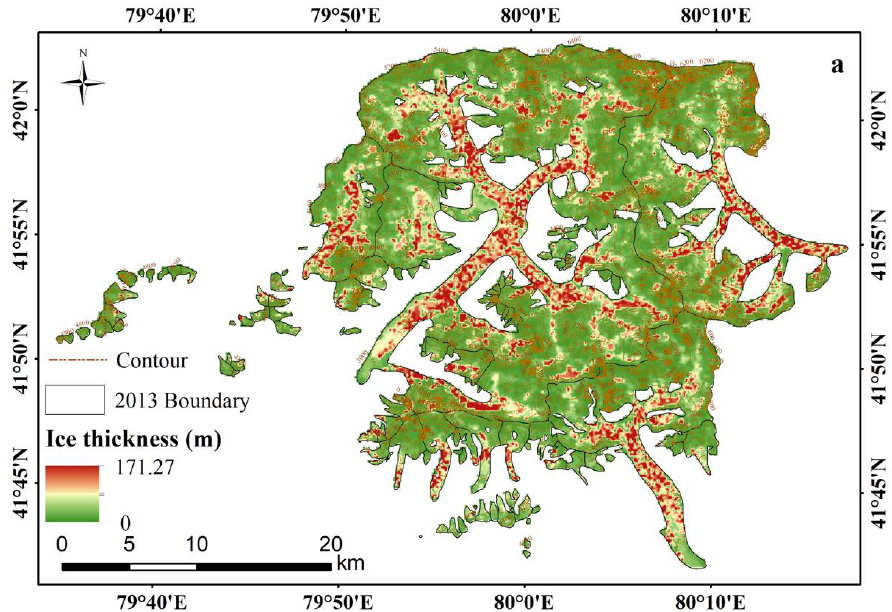
Figure 4. Glacier ice thickness distribution in the Tomur region in 2013.